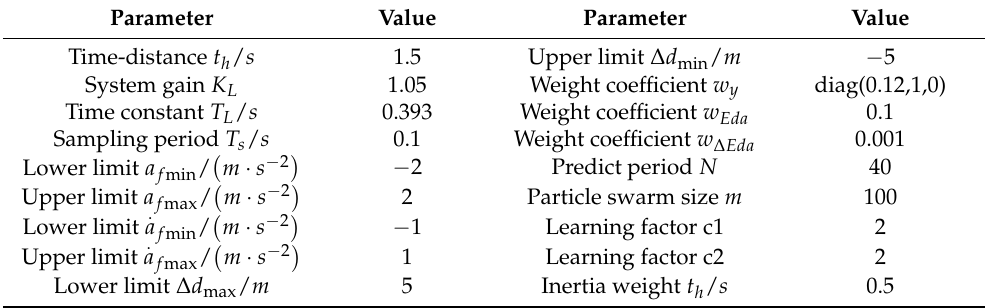
Table 1. The simulation parameters.